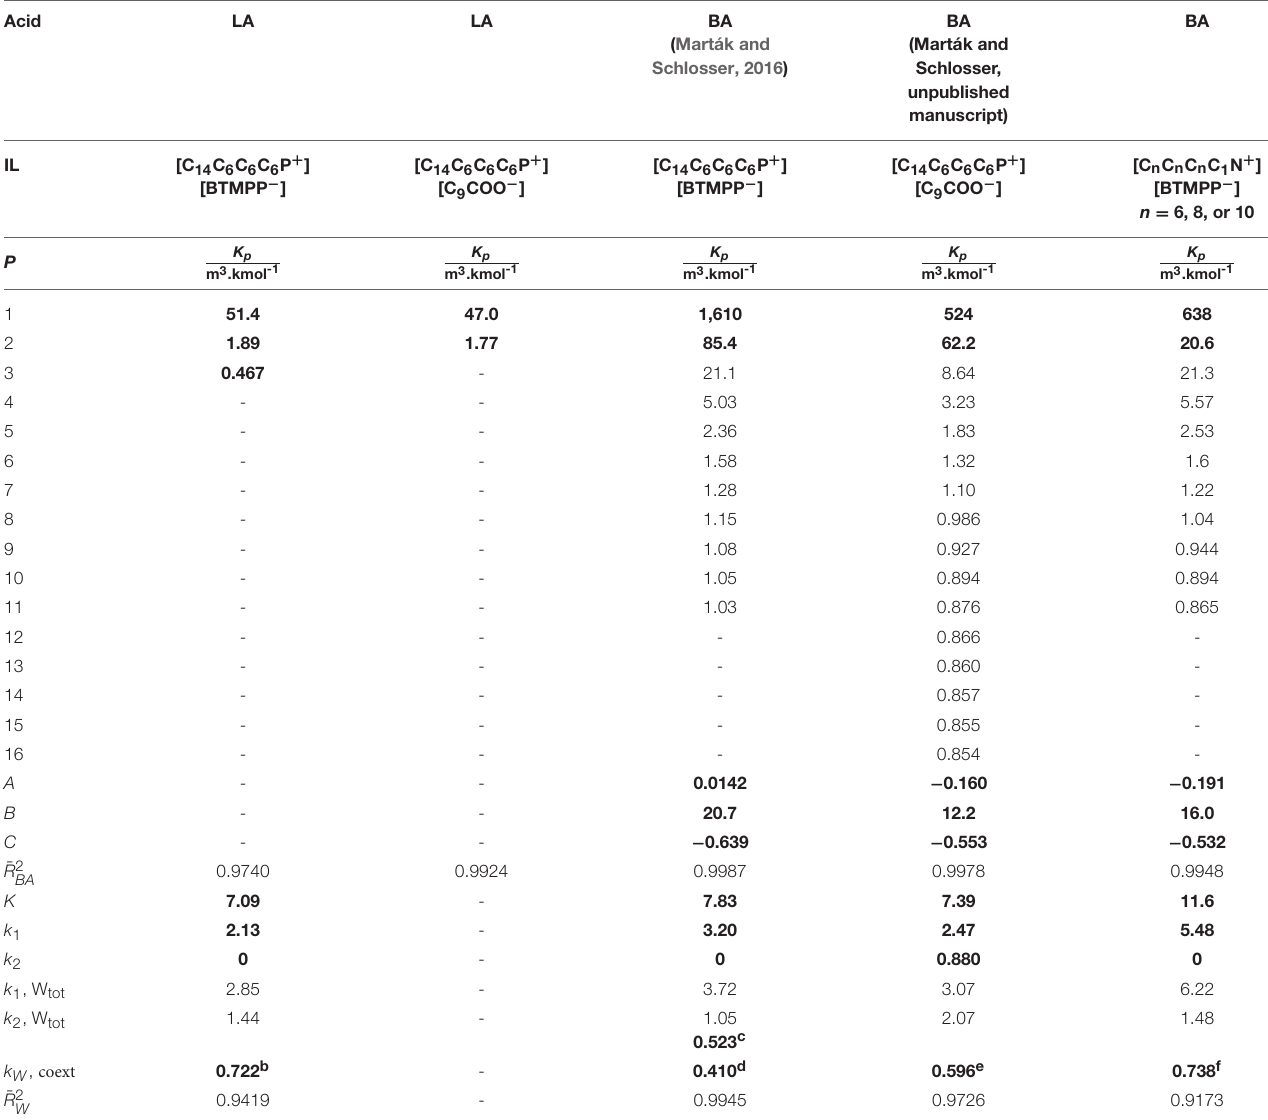
TABLE 2 | Values of parameters K p , A , B , C , k , k 1 , k 2 , k 1,Wtot , k 2,Wtot , and K W,coext resulting from the fitting of the data on (Liquid-Liquid) equilibrium in the system (IL + dodecane + acid + water) by the studied model. Acid LA LA BA